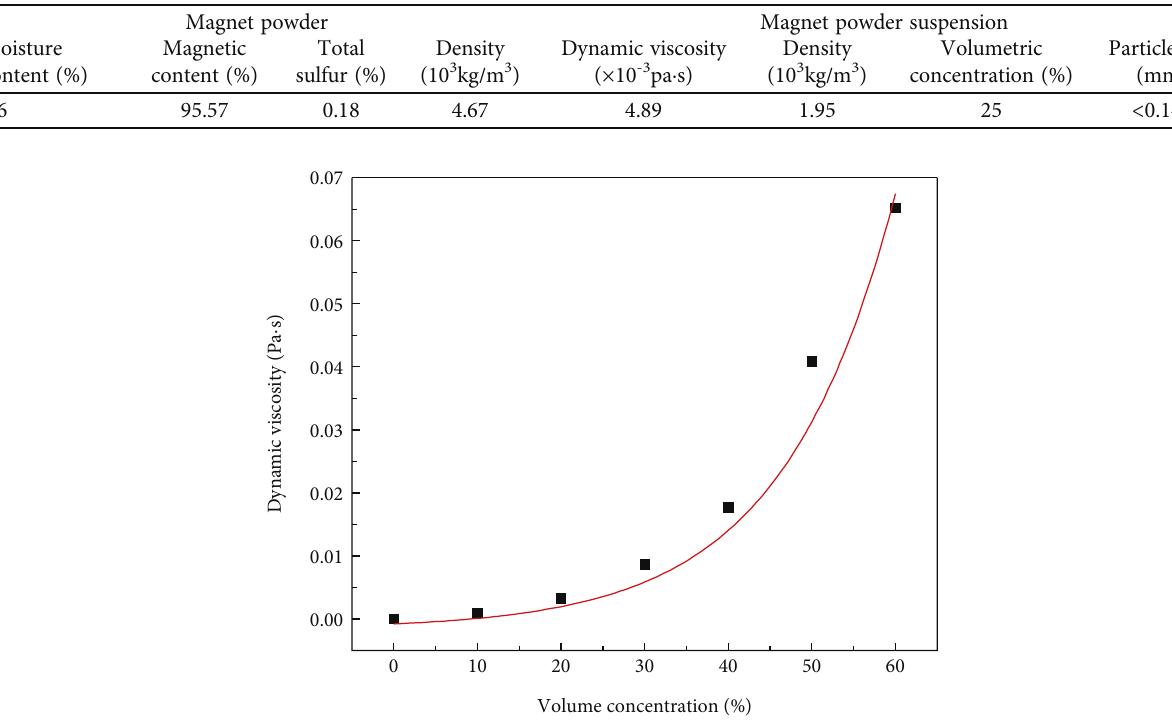
Figure 1: Relationship between suspension dynamic viscosity and volumetric